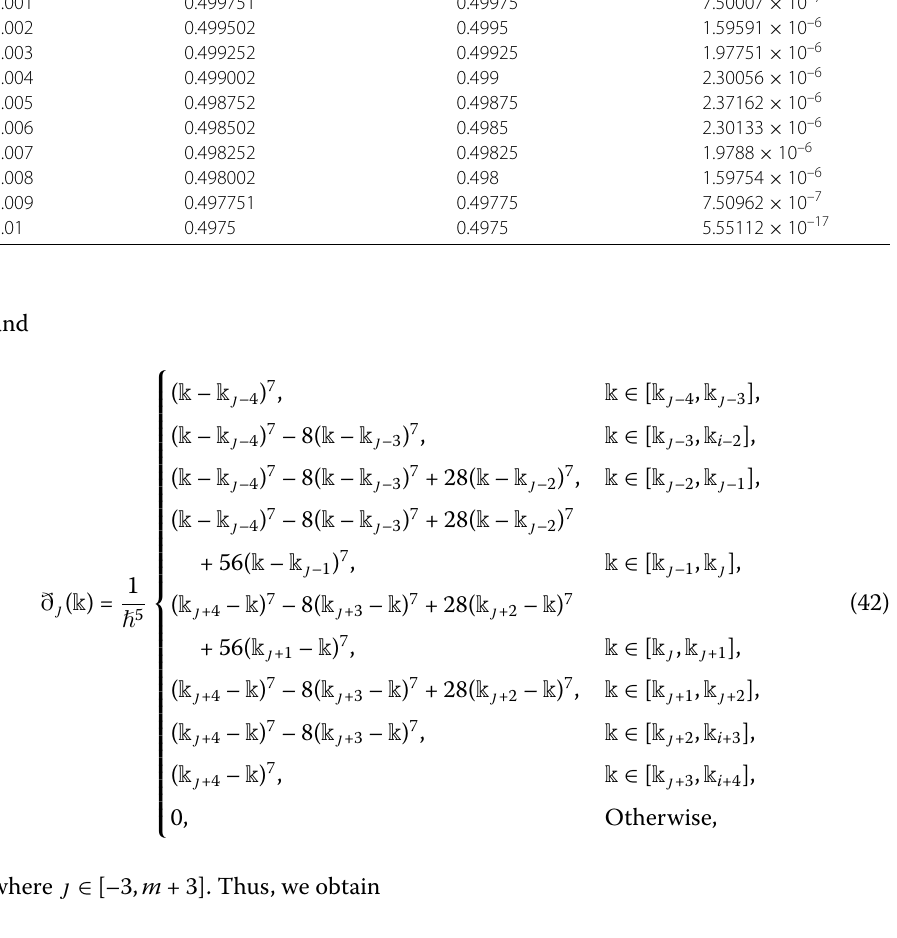
Table 3 Analytical, numerical, and absolute values in different values of k via septic B-spline scheme, showing the accuracy of the obtained analytical solution Value of k Approximate values Analytical values Absolute values of error 0 0.5 0.5 0 0.001 0.499751 0.49975 7.50007 × 10 –7